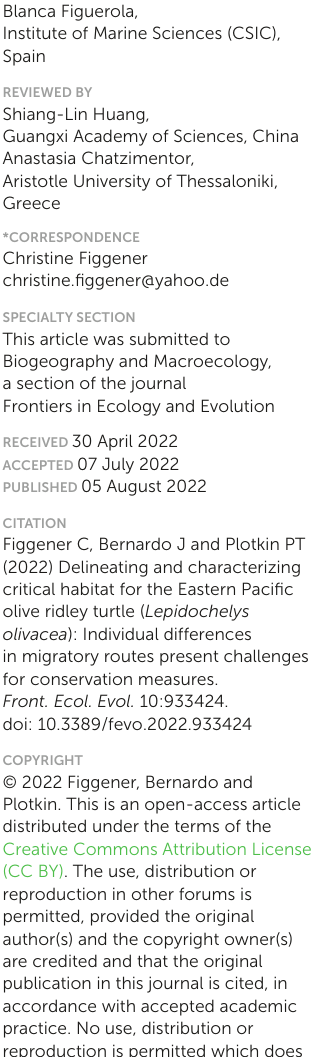
CITATION Figgener C, Bernardo J and Plotkin PT (2022) Delineating and characterizing critical habitat for the Eastern Pacific olive ridley turtle ( Lepidochelys olivacea ): Individual differences in migratory routes present challenges for conservation